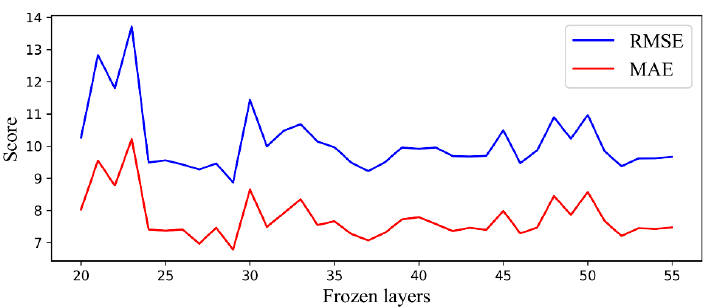
Figure 11. Performance of TCN under different frozen layers.